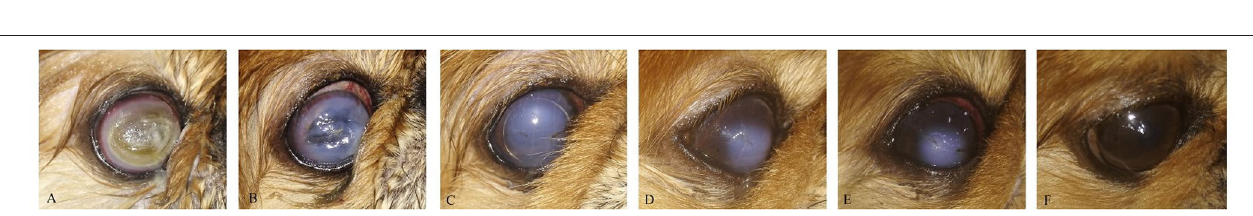
FIGURE 8 | A photography series of Pekingese dog showing (A) melting ulceractive keratitis (B–F) gradual healing and reduction of keratitis after 2-week post-injection till complete healing at 3